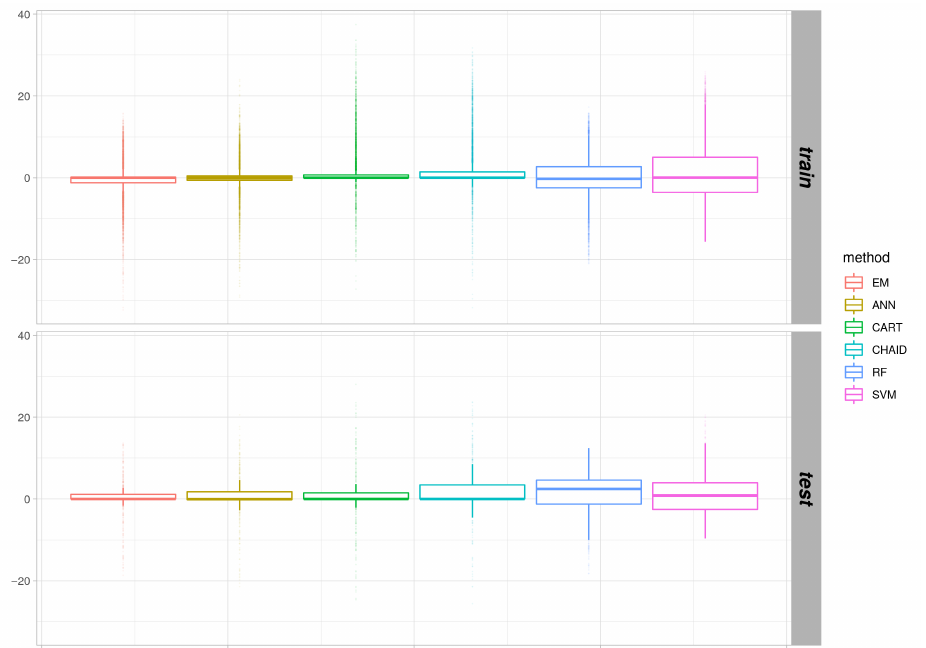
Figure 5. The train and test errors of the six models when the training was set to 7